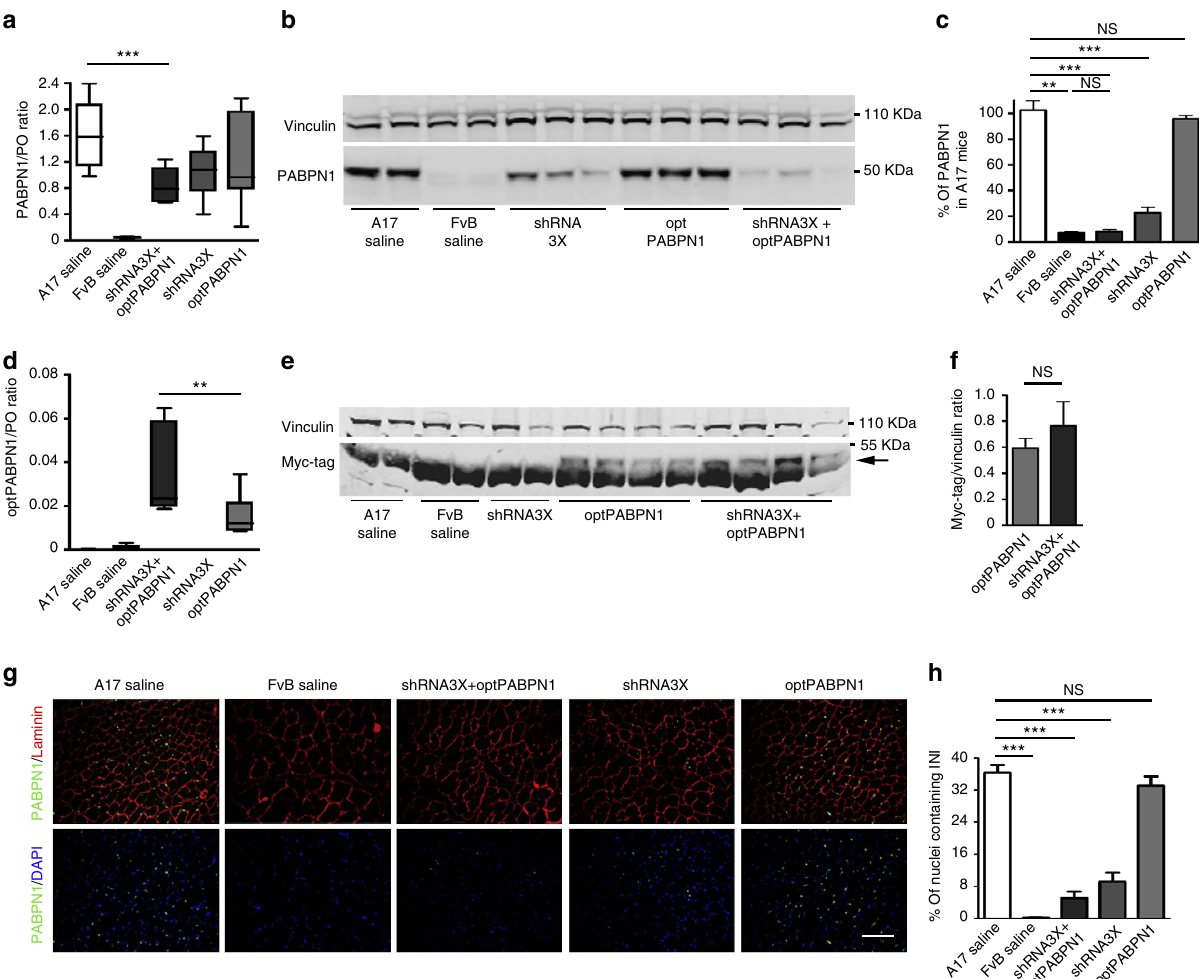
Figure 2 | Tricistronic shRNA delivered in vivo by AAV vectors efficiently downregulates endogenous PABPN1 without affecting optPABPN1 expression in vivo . Eighteen weeks after intramuscular AAV injections, TA muscles were collected and expression of PABPN1 was analysed. ( a ) qRT-PCR analysis of PABPN1 mRNA normalized to the housekeeping gene RplP0 mRNA shows a statistically significant decrease in PABPN1 expression in muscles injected with shRNA3X and optPABPN1 compared with muscles injected with saline. ( b ) Western blot for PABPN1 expression shows that the treatments with AAV-shRNA3X alone or in combination with AAV-optPABPN1 significantly knock down the endogenous PABPN1. ( c ) Densitometric analysis of western blot for PABPN1 detection shows statistically significant reduction in protein expression when muscles are treated with shRNA3X (with or without optPABPN1 expression) compared to the level of A17 muscles. PABPN1 expression was normalized to the relative vinculin expression. ( d ) qRT-PCR